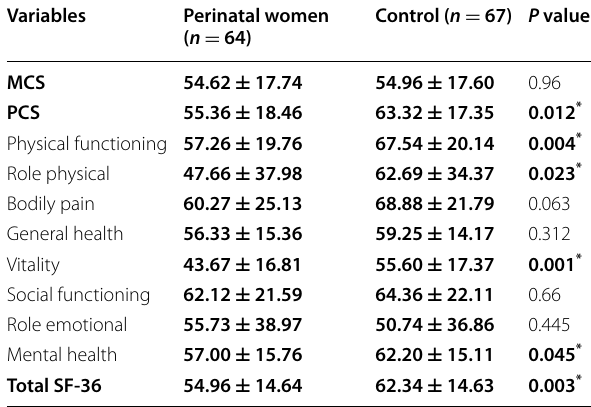
Table 4 Quality of life among different studied groups according to